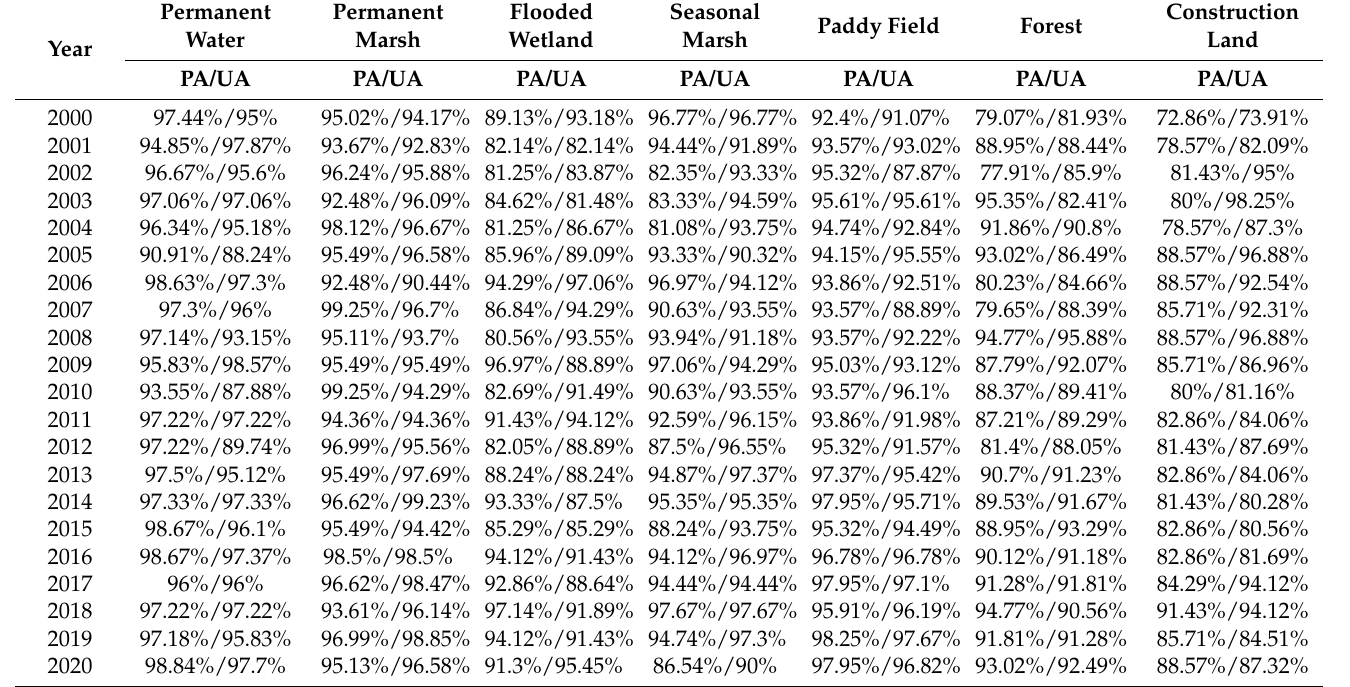
Figure 4. Overall accuracy (OA) and kappa coefficient for each year. Table 3. Classification accuracy for each year.